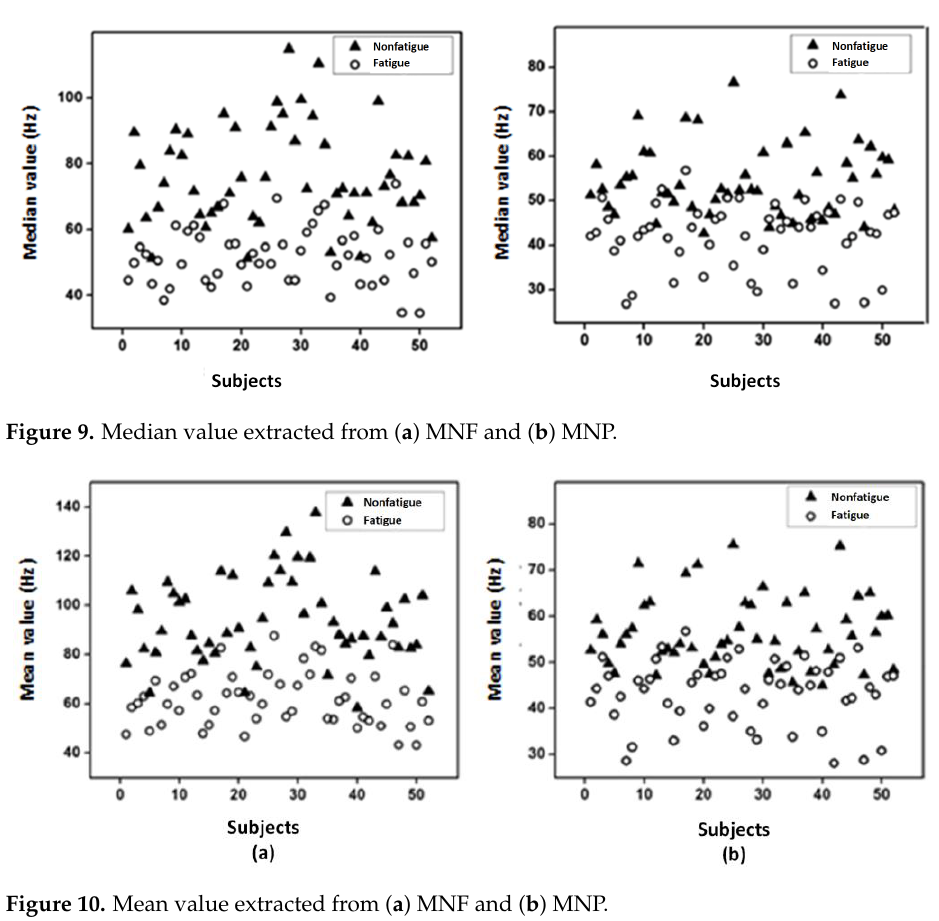
Figure 10. Mean value extracted from ( a ) MNF and ( b ) MNP.